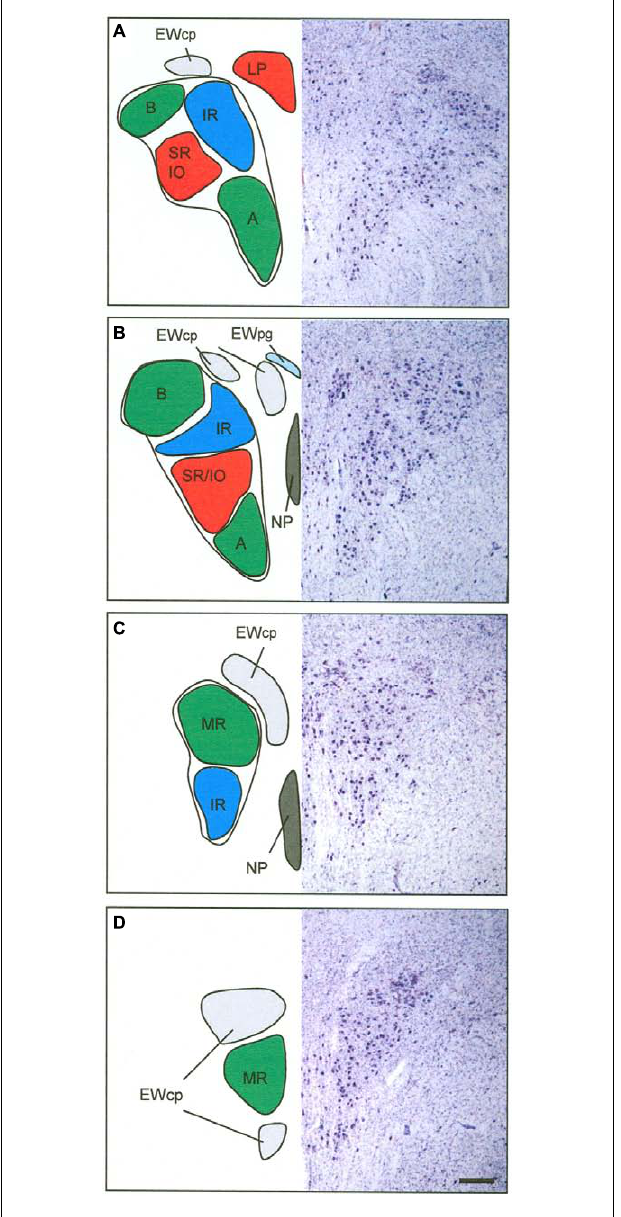
FIGURE 8 | Proposed map of the motoneurons for individual extraocular muscles in human shown at four representative planes from caudal to rostral. The right half shows corresponding sections in Nissl staining to demonstrate the cytoarchitecture.The central caudal nucleus at most caudal planes contains the motoneurons of the levator palpebrae muscle (LP) (A) .The medial rectus muscles (MR) is represented in two groups, the dorsolateral B- and the ventral A-group (A,B) .The central group represents the motoneurons of the inferior oblique (IO) and superior rectus (SR) muscle (A,B) .The nucleus of Perlia (NP) is separated from the main nucleus, but may contain SR motoneurons as well (B,C) .The dorsomedial group corresponds to the inferior rectus motoneurons (IR) (A–C) .The centrally projecting neurons of the Edinger–Westphal nucleus (EWcp) appear as a single lateral group on caudal levels dorsal to nIII (A) , adjoined by a medial group further rostrally (B) , which both merge to a single dorsal group (C) . Another ventral extension of the EWcp appears on rostral levels (D) . Note that the preganglionic neurons in the EWpg do not form a compact nucleus (B) . Scale bar: (A–D) 500 μ